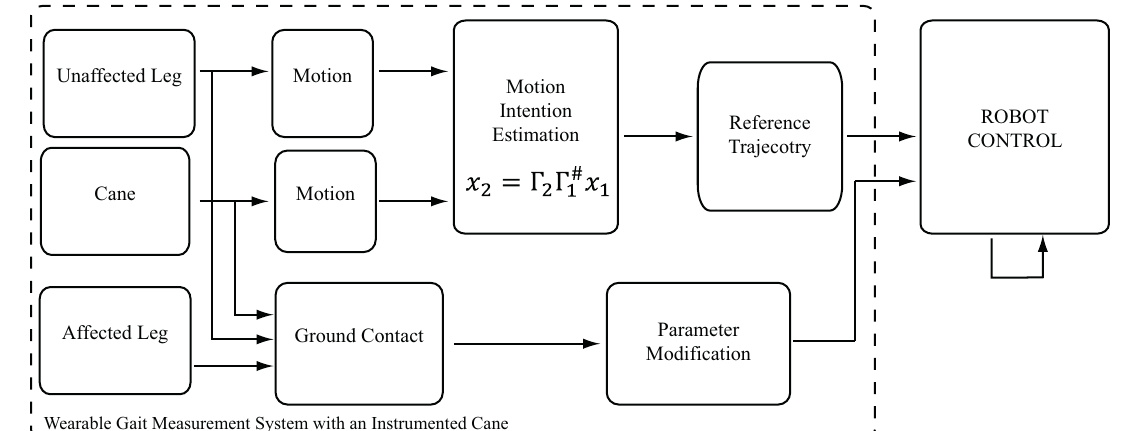
Figure 5. Schematic diagram of the control system in continuous